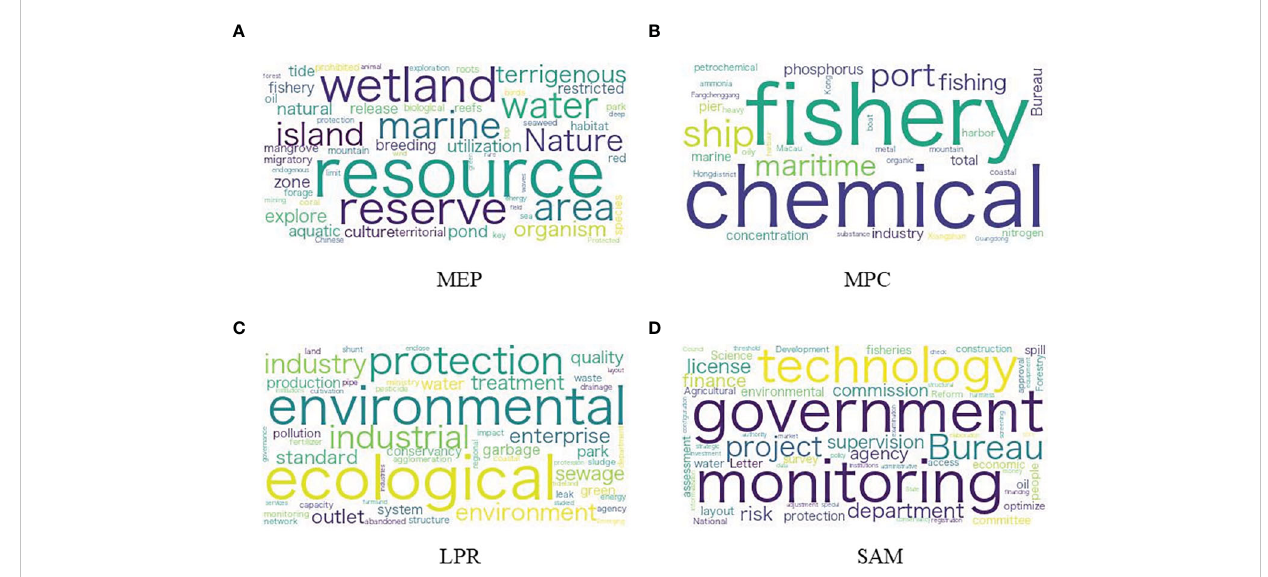
FIGURE 8 Cloud map of high-frequency words in the policy texts of governments: (A) High-frequency words in the MEP theme, (B) High-frequency words in the MPC theme, (C) High-frequency words in the LPR theme, (D) High-frequency words in the SAM